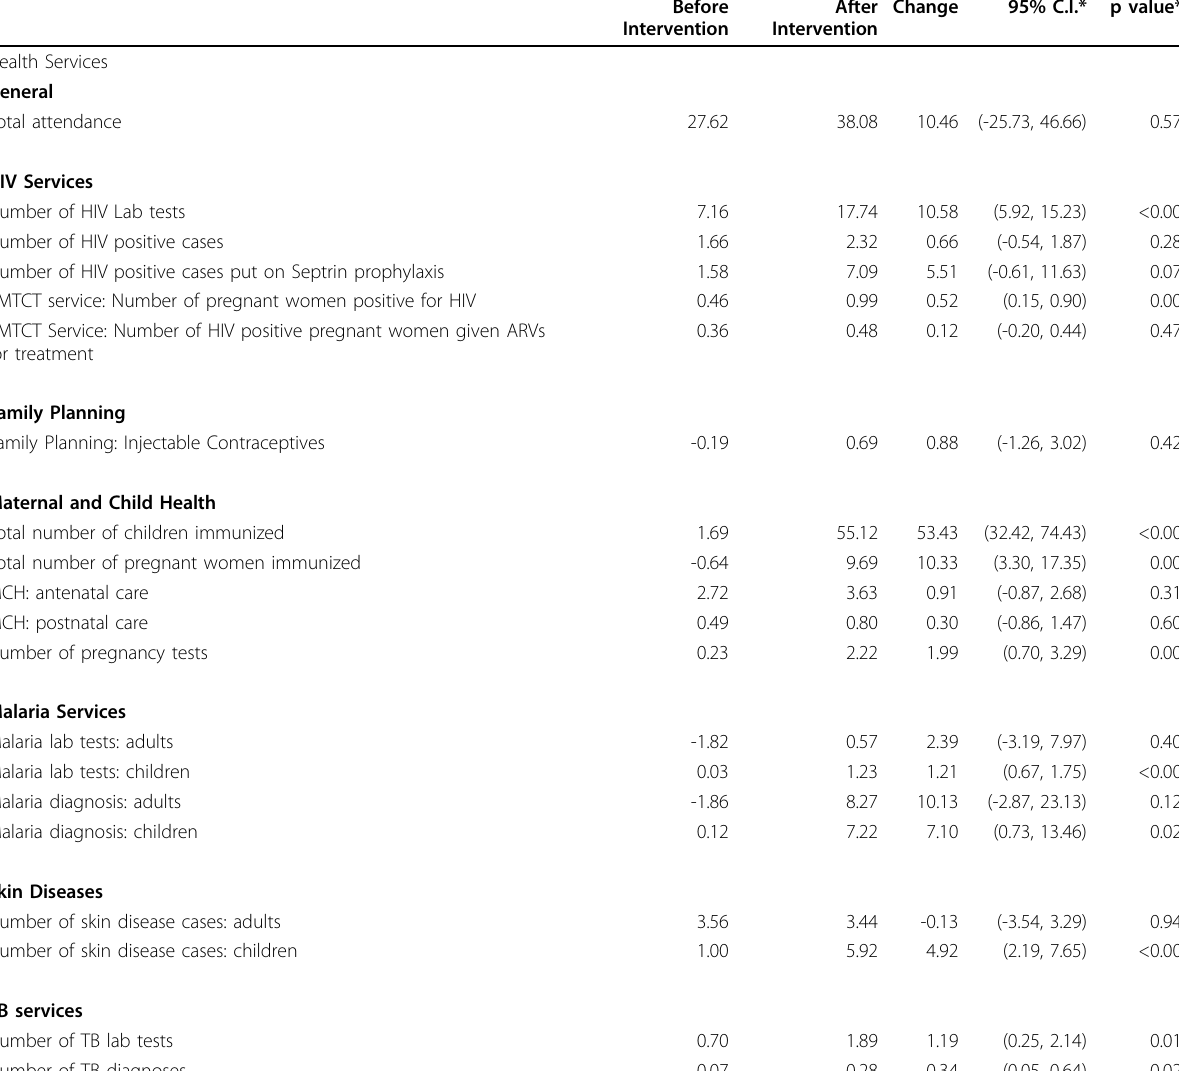
Table 2 Monthly trend in delivery of health services at a clinic level